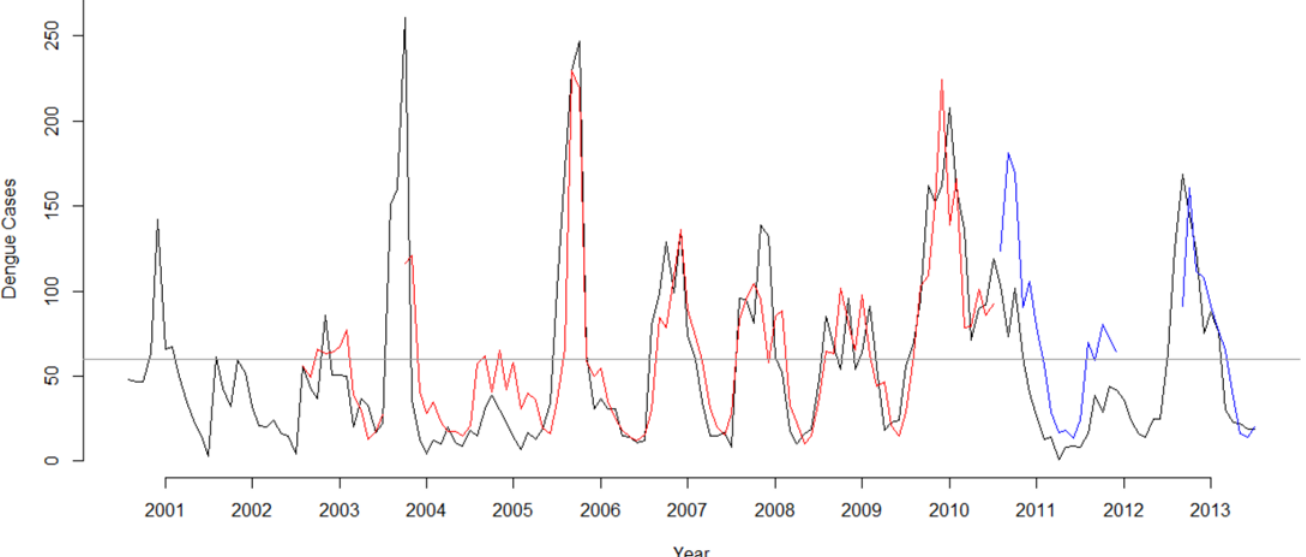
Fig 7. Predicted Dengue Cases Versus Reported Dengue Cases in 2001 – 2013. Monthly predicted dengue cases compared with reported cases during January 2001 to December 2013. Black line represents observed dengue cases, grey line represents the epidemic threshold, red line represents predicted cases using training dataset, and blue line represents predicted cases using the external validation dataset not used for model fitting.